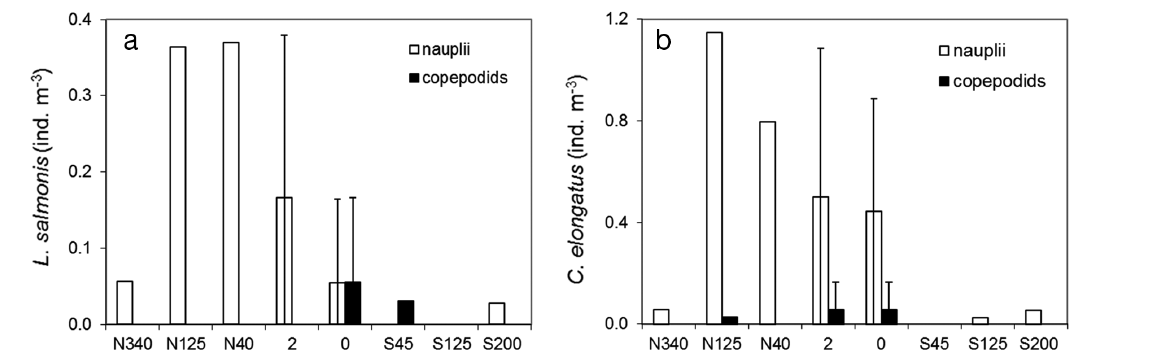
Fig. 3. Abundance of (a) Lepeophtheirus salmonis and (b) Caligus elongatus at various distances downstream (N) and upstream (S) of the fish farm. The numbers denote the distance from the farm (in m). Open bars: nauplii, closed bars: copepodids. Values